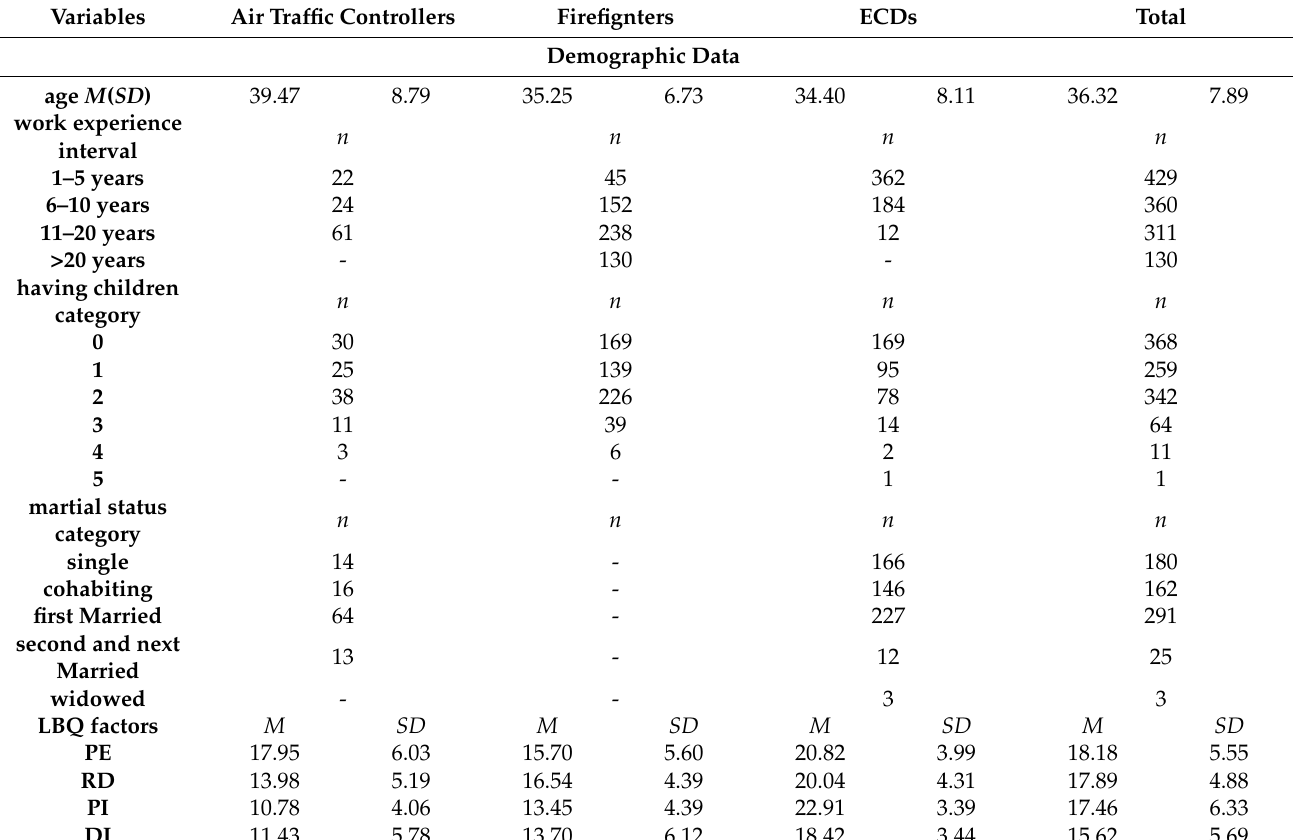
Table 1. Characteristics of the group of participants N =